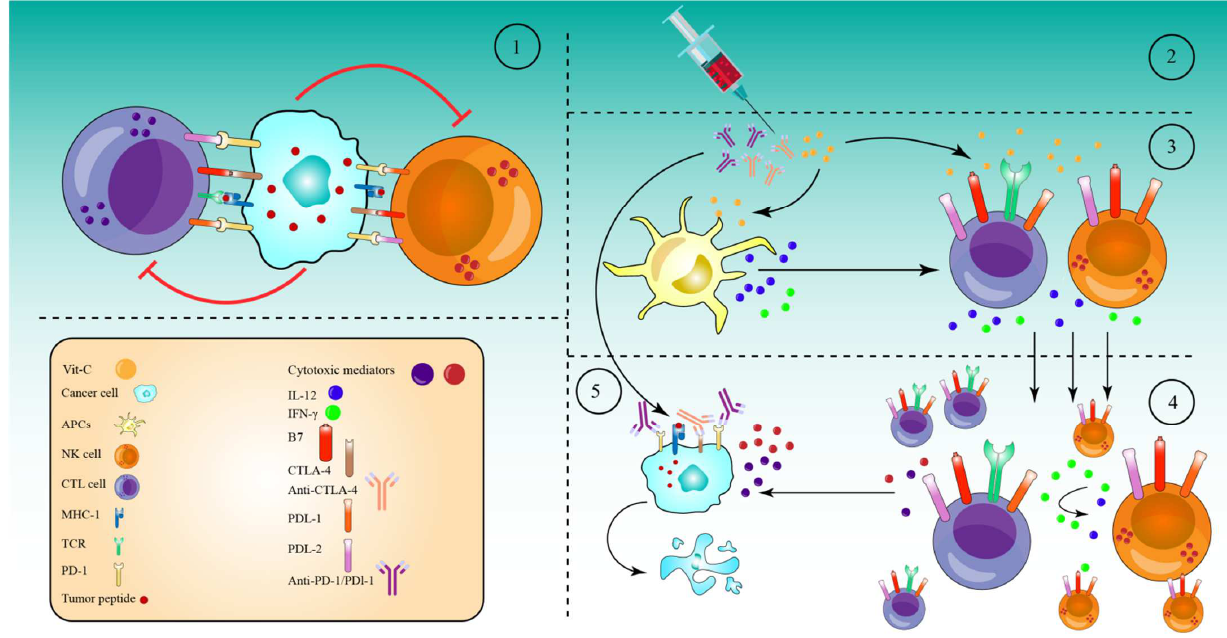
Figure 5. Systematic effect of high-dose Vit-C on cancer immunotherapy. (1) Cancer cells resist and inhibit the immune response to prevent successful cancer eradication. (2) High-dose Vit-C combined with ICP therapy. (3) High-dose Vit-C activates APCs to increase cytokines (IL-12 and IFN-γ), and also enhances the phagocytic activity of the APCs; in addition, high-dose Vit-C can also activate and increase the intratumoral infiltration of both CTLs and NK cells. (4) As a result, these cells in turn produce more cytokines, chemokine, and cytotoxic mediators (perforin and garnzyme). (5) The ICP therapies bind to their target proteins on cancer cells and make them susceptible to potential cellular lysis mediated by CTLs and NK. ICP, immune check point; Vit-C, vitamin-C; APCs, antigen presenting cells; IFN-γ, interferon gamma; IL-12, interleukin 12; NK cells, natural killer cells; CTLs, cytotoxic T lymphocytes.